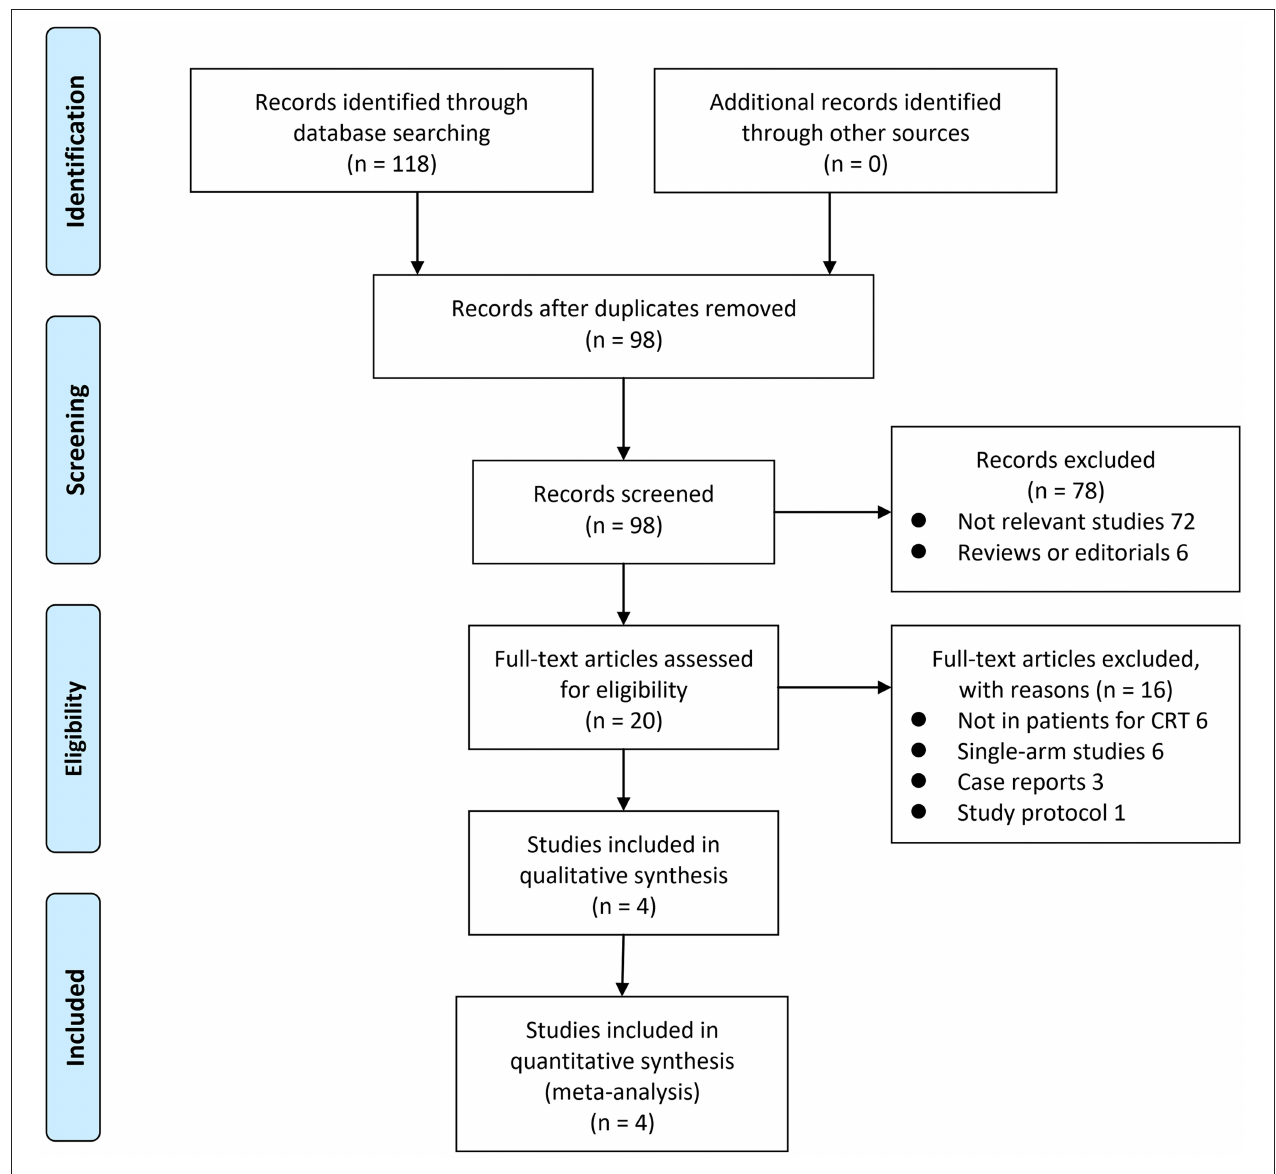
FIGURE 1 | Flowchart of database search and study